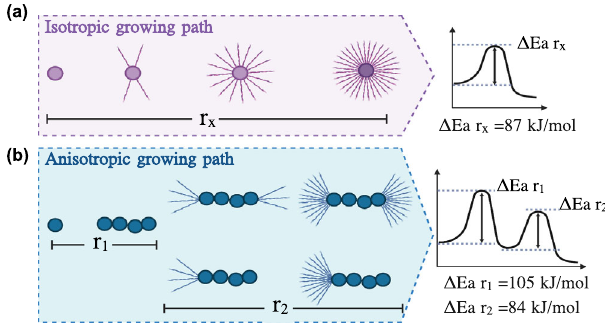
Fig. 5 Schematic representation of the diverse pathways of insulin aggregation and their respective energy barriers. a Isotropic spherulite growth, where fi bril-like fi laments isotropically and radially grow on a dense core. Process is characterized by a single activation energy of 87